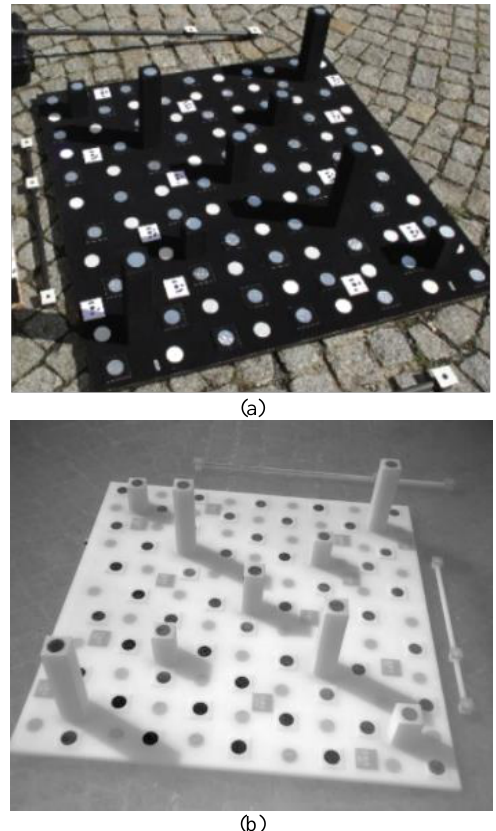
Figure 3. 3D Geometric Calibration Field: (a) RGB Image (b) Thermal Image